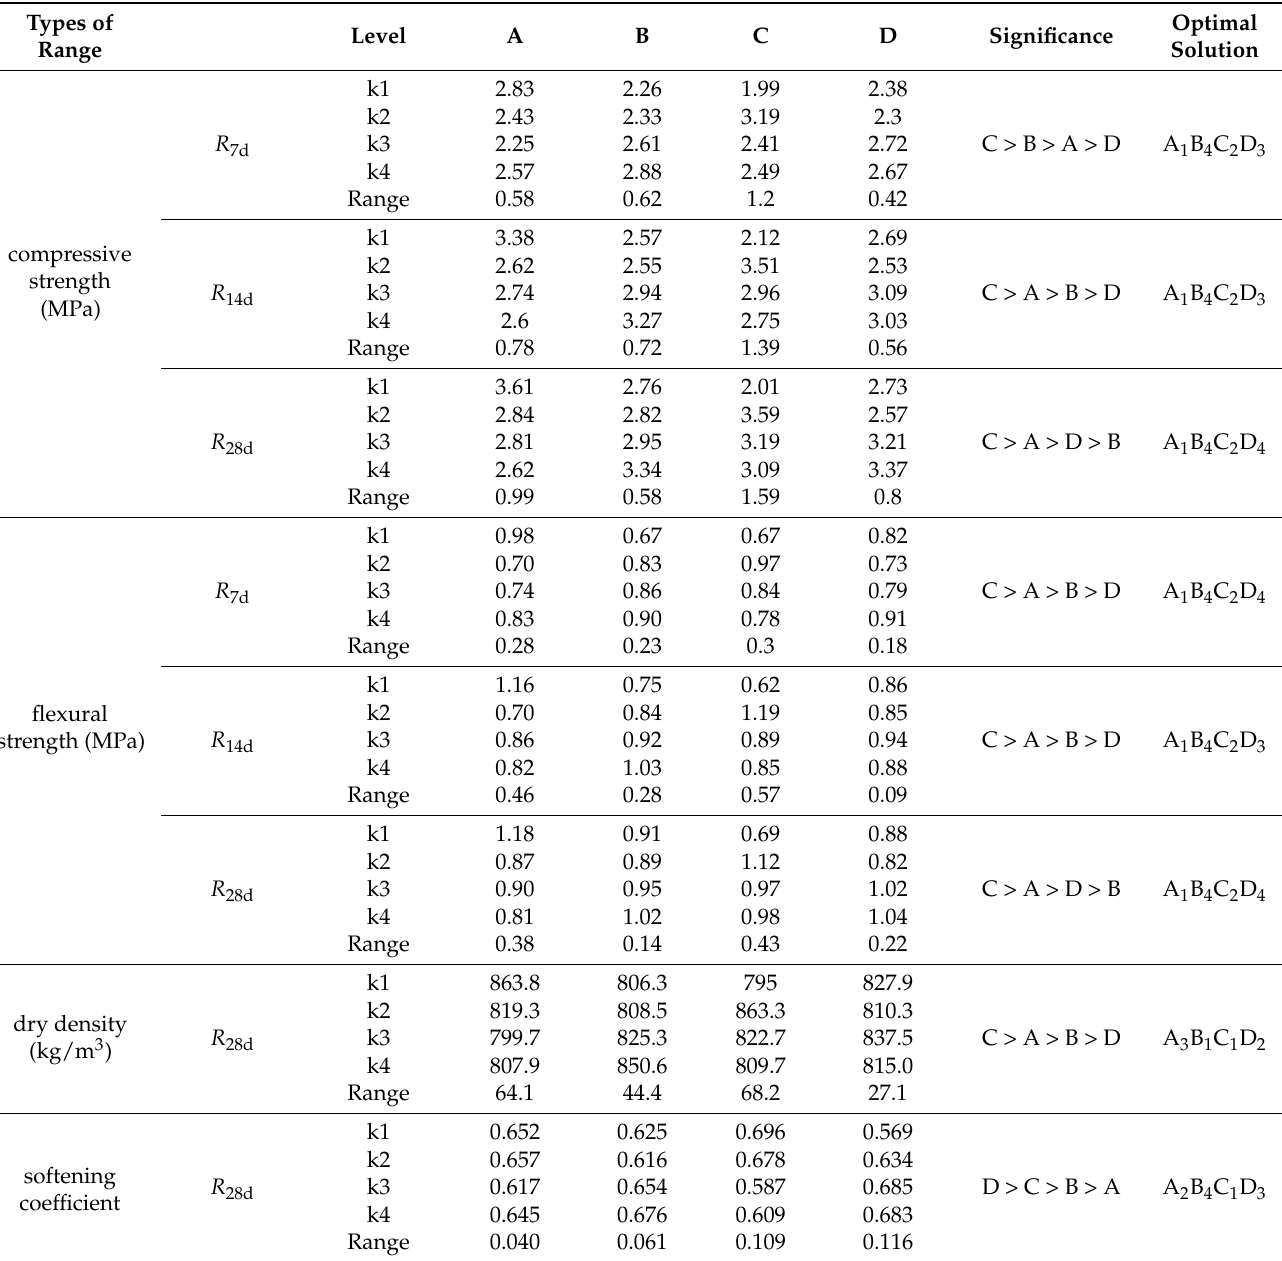
Table 5. Results of range